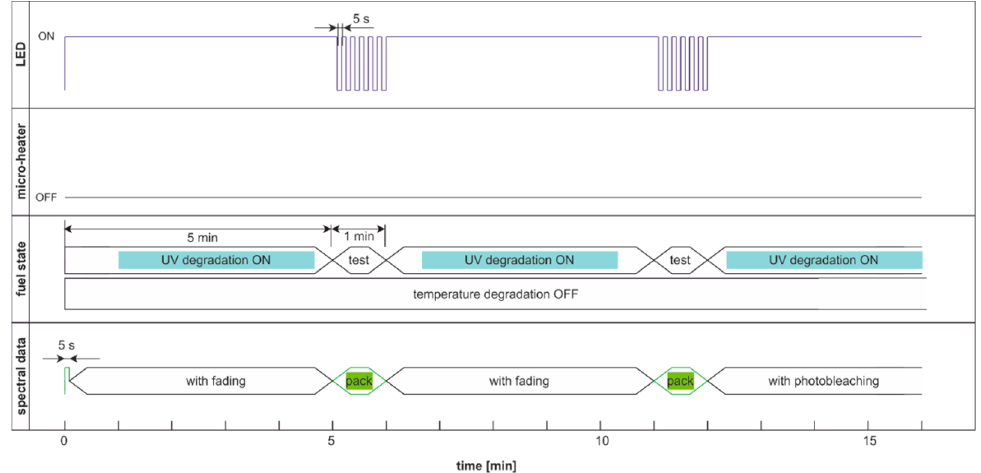
Figure 20. Degradation and examination cycle of fuel with double modulated UV radiation named DME:UVonToff.